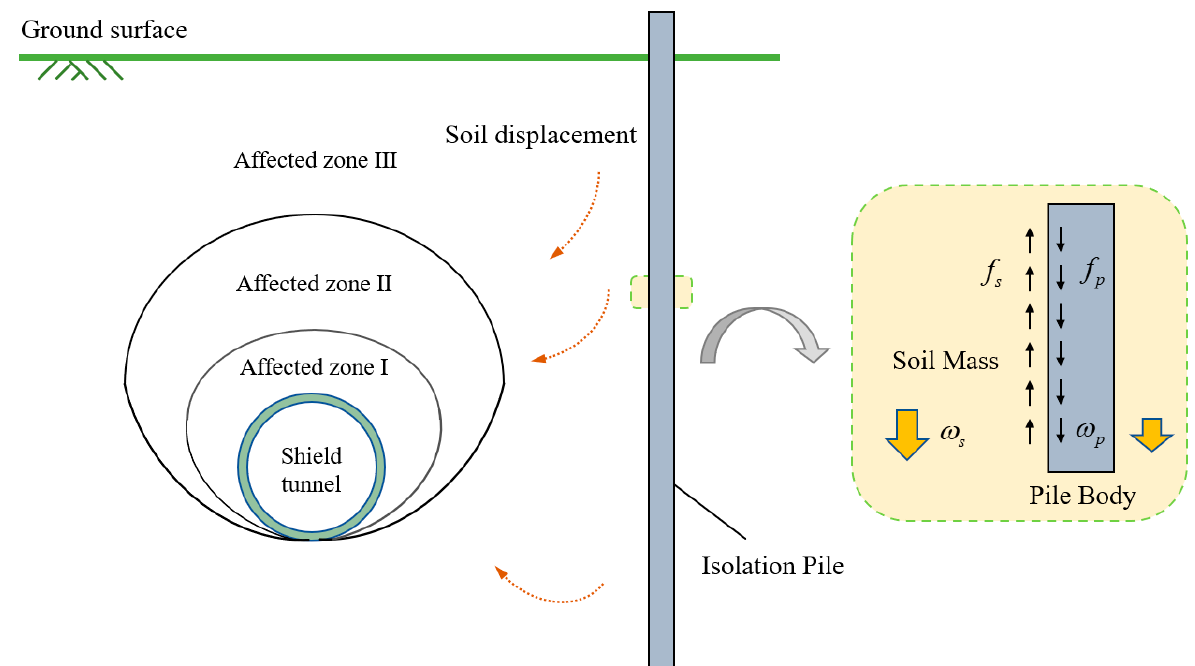
Figure 1. Pile-soil-tunnel interaction mechanism.